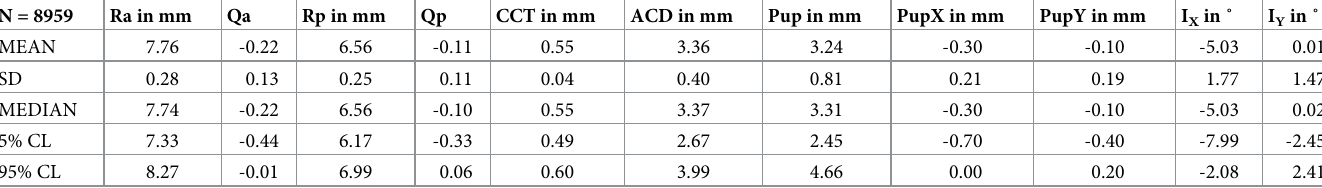
Table 1. Explorative data extracted from the dataset of the Casia2 anterior segment tomograph. Ra, Qa, Rp, Qp, CCT, ACD, Pup, Pup X , Pup Y , I X , I Y refer to the cor- neal front surface curvature and asphericity, corneal back surface curvature and asphericity, central corneal thickness, anterior chamber depth measured from the corneal front apex, lateral position of the pupil centre in X (positive values in the nasal direction) and Y (positive valuesin the superior direction), and simulated incident ray angle in X and Y. Right eyes were flipped in X. MEAN, SD, MEDIAN, 5% CL, and 95% CL refer to mean value, standard deviation, median, and 90% confidence interval,